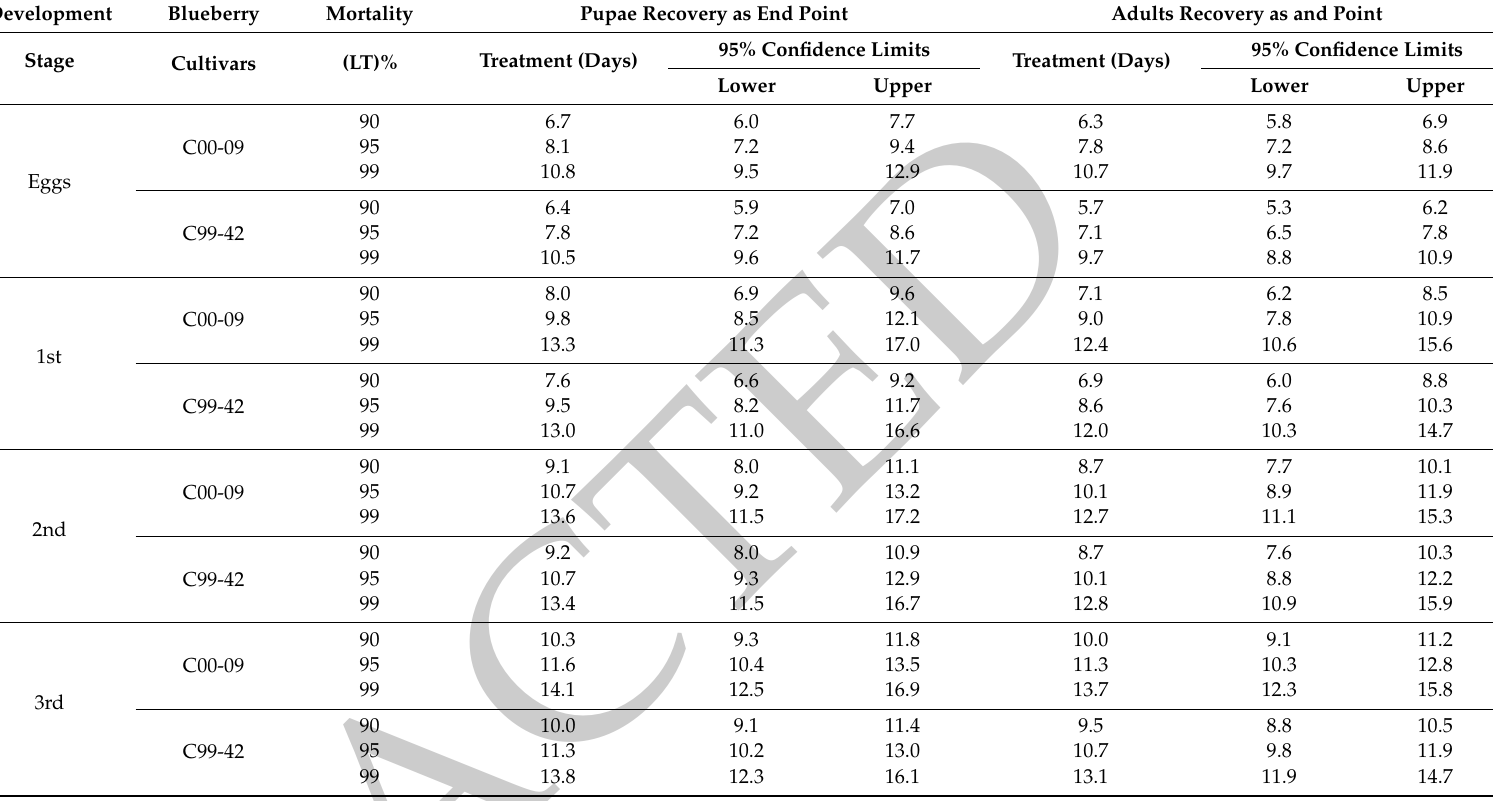
Table 3. Cold treatment duration to induce 90%, 95%, and 99% mortality of C.